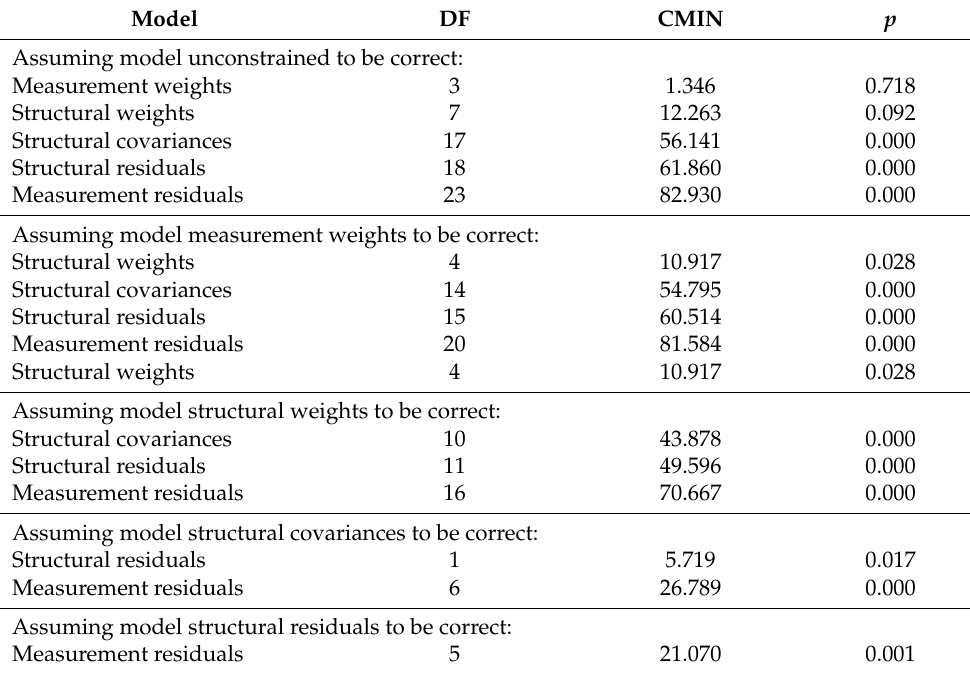
Table 3. Full out study of significant difference between